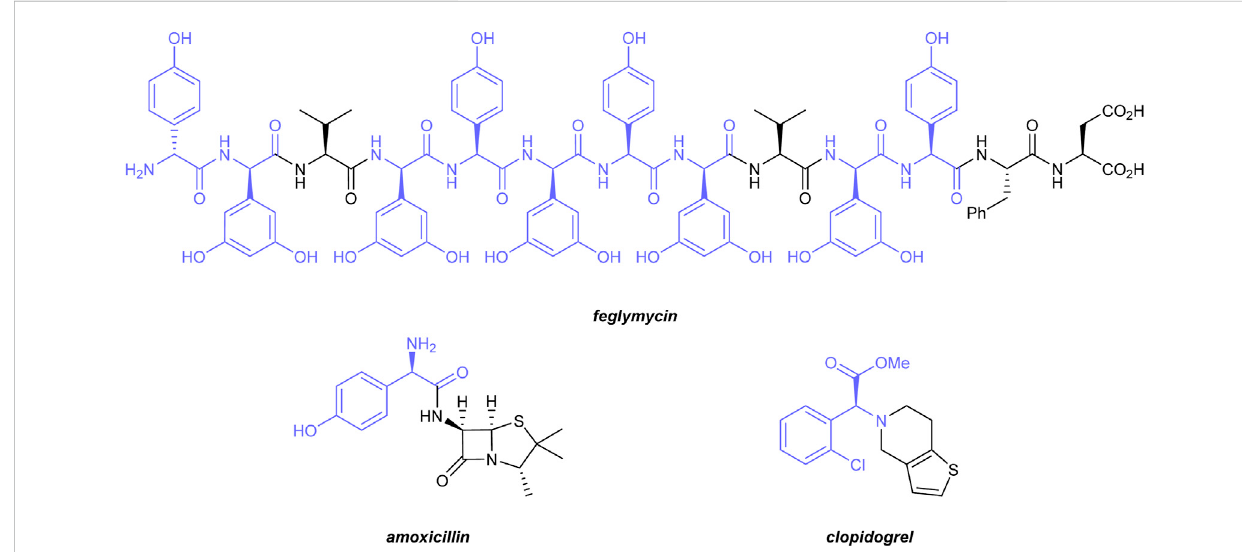
Biologically active molecules containing α -arylglycine motifs (highlighted in